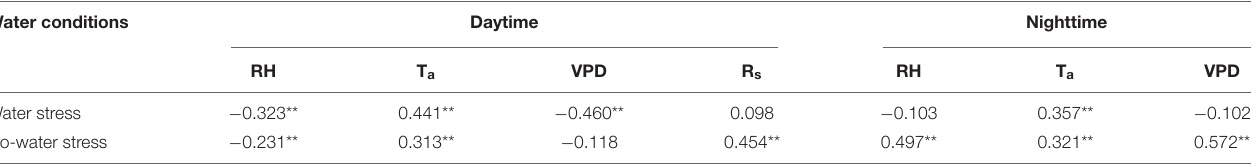
TABLE 4 | Partial correlation between sap flow velocity and meteorological factors under different water